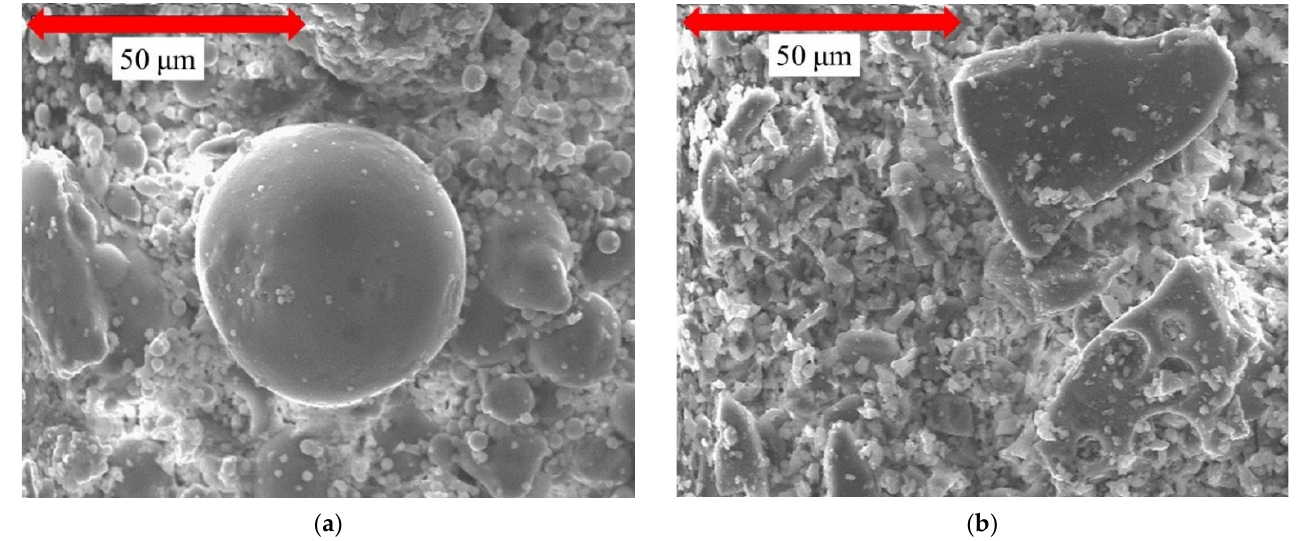
Figure 14. Scanning electron microscopy (SEM) microphotographs: ( a ) Fly ash; ( b ) Bottom ash.